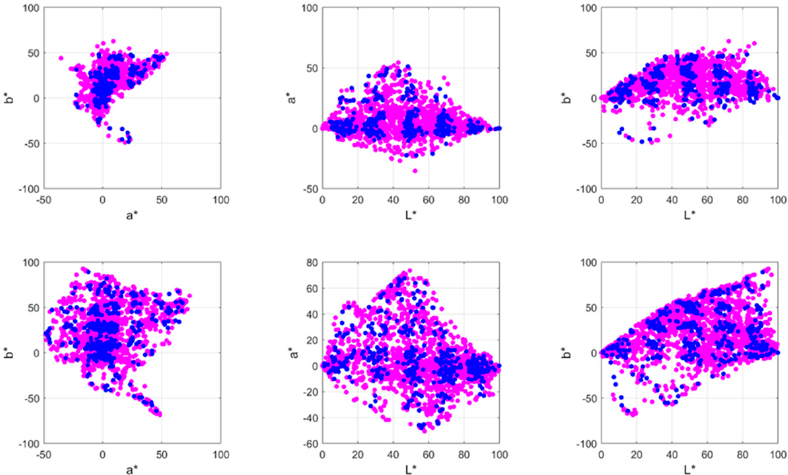
Figure 5. All computational (blue points) and subjective (magenta circles) relevant colours obtained from all observers. The upper row corresponds to the Prado museum paintings, and the lower row corresponds to the Khan image dataset.